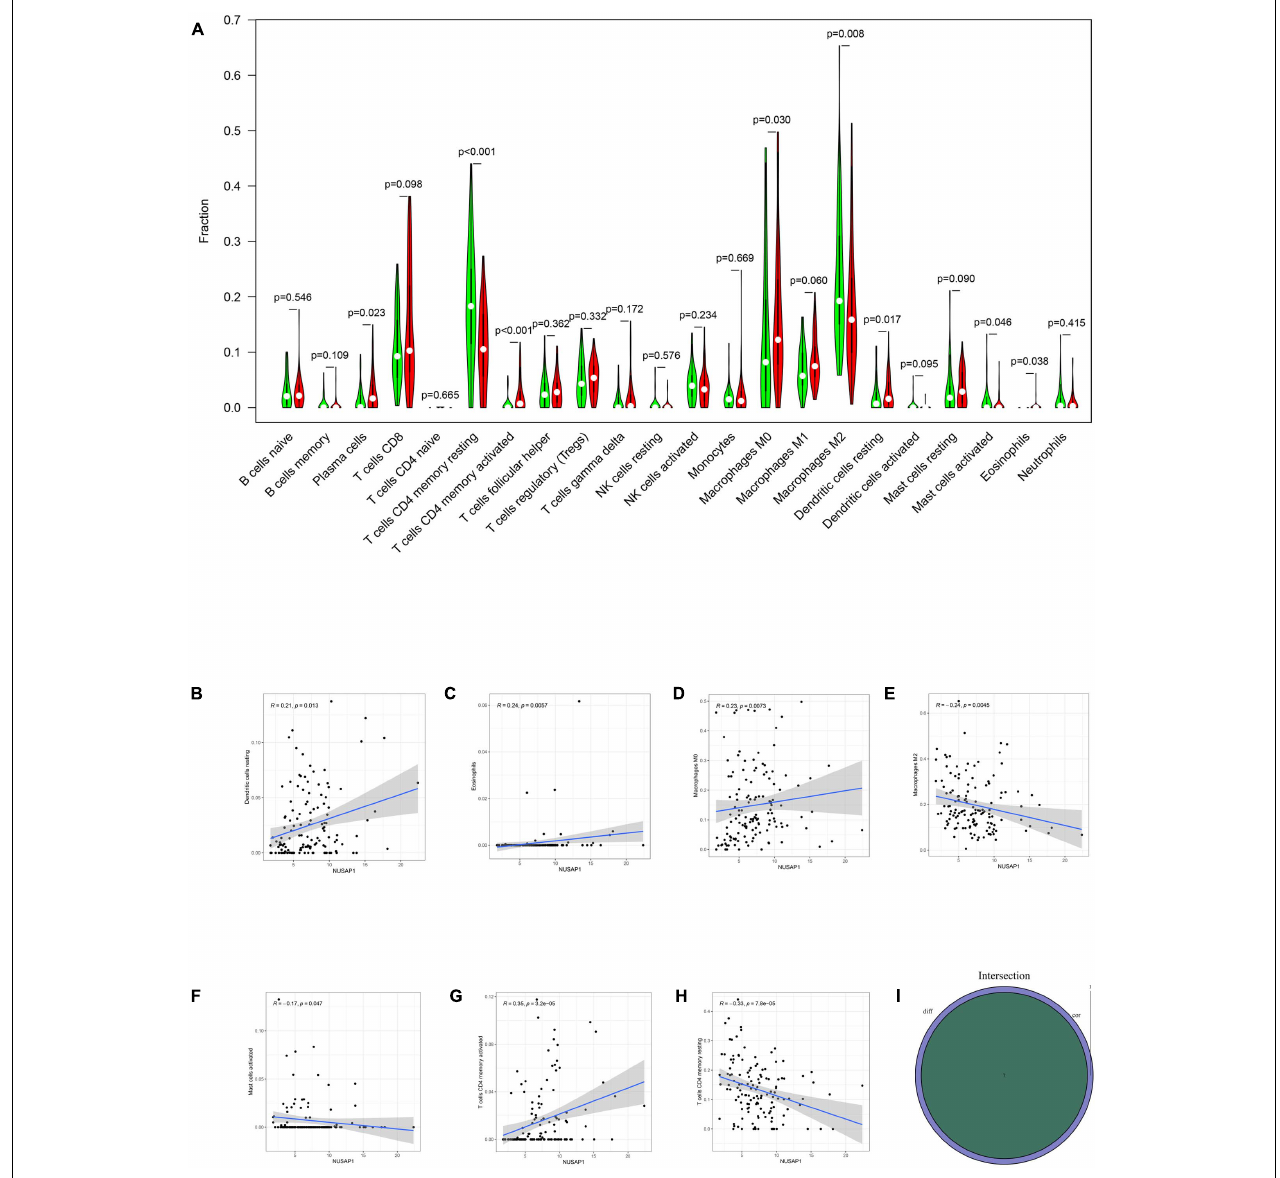
FIGURE 12 | Bar plot, violin plot, correlation diagrams, and Venn diagram. All pictures were drawn by HCC patients’ information in GSE76427 dataset, ICGC database, and TCGA database. (A) Violin plot, which proved 22 immune cells whether they exhibited difference between high expression group and low expression group. (B) The correlation diagram between NUSAP1 and dendritic cells resting. (C) The correlation diagram between NUSAP1 and eosinophils. (D) The correlation diagram between NUSAP1 and macrophages M0. (E) The correlation diagram between NUSAP1 and macrophages M2. (F) The correlation diagram